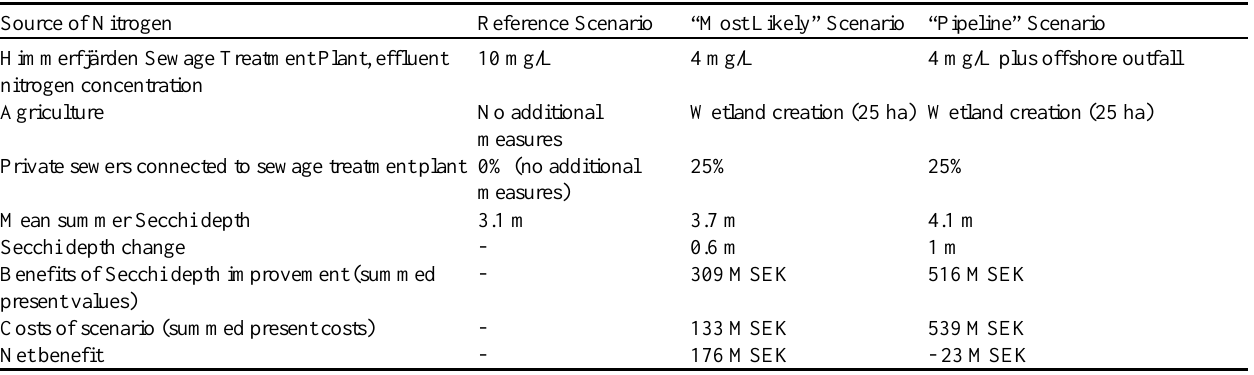
Table 2 . Results for the three main